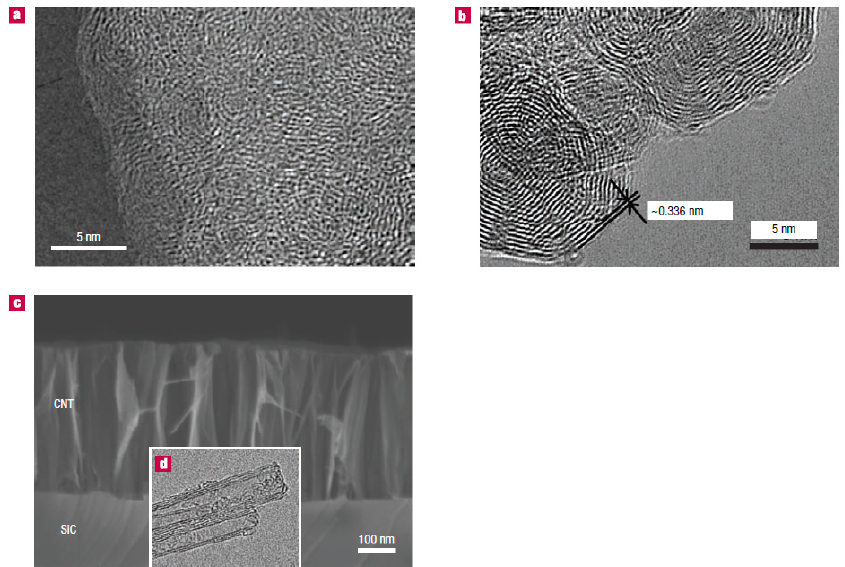
Figure 14. Transmission electron microscope images of different carbon structures used as active materials for double-layer capacitors: ( a ) disordered microporous carbon; ( b ) onion-like carbon; ( c ) SEM image of carbon nanotubes on SiC; ( d ) carbon nanotubes. Adapted with permission from the Springer Nature Customer Service Center GmbH [237].